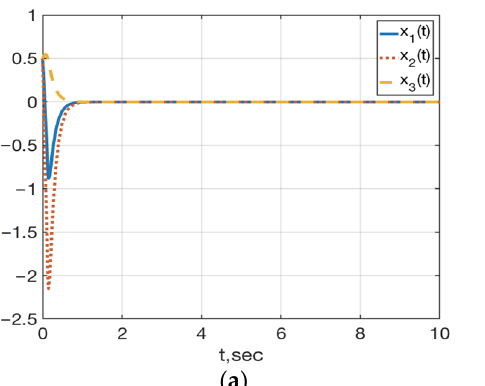
Corresponding graphs for the closed-loop system xBFAx )9.01.1( +=